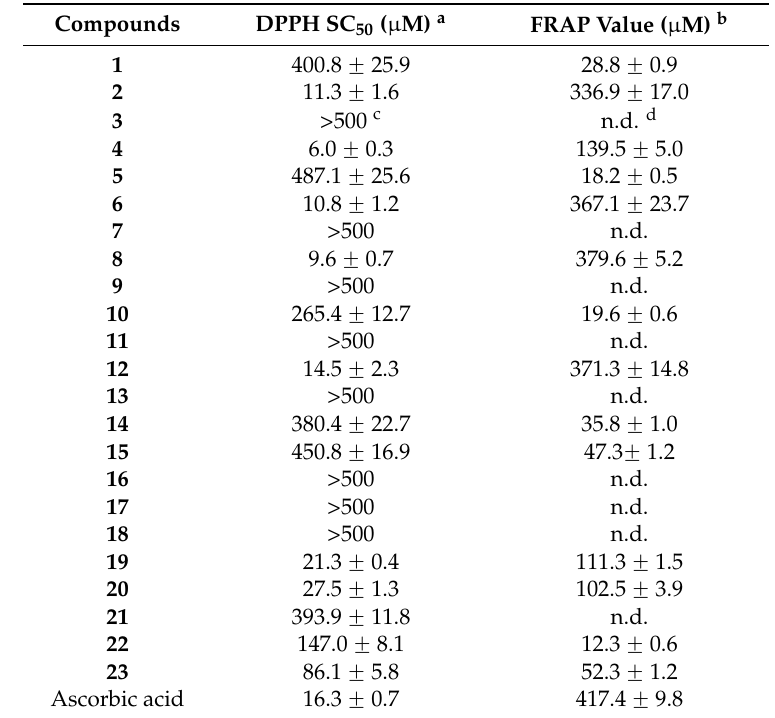
Table 2. Antioxidant activity of compounds 1 – 23